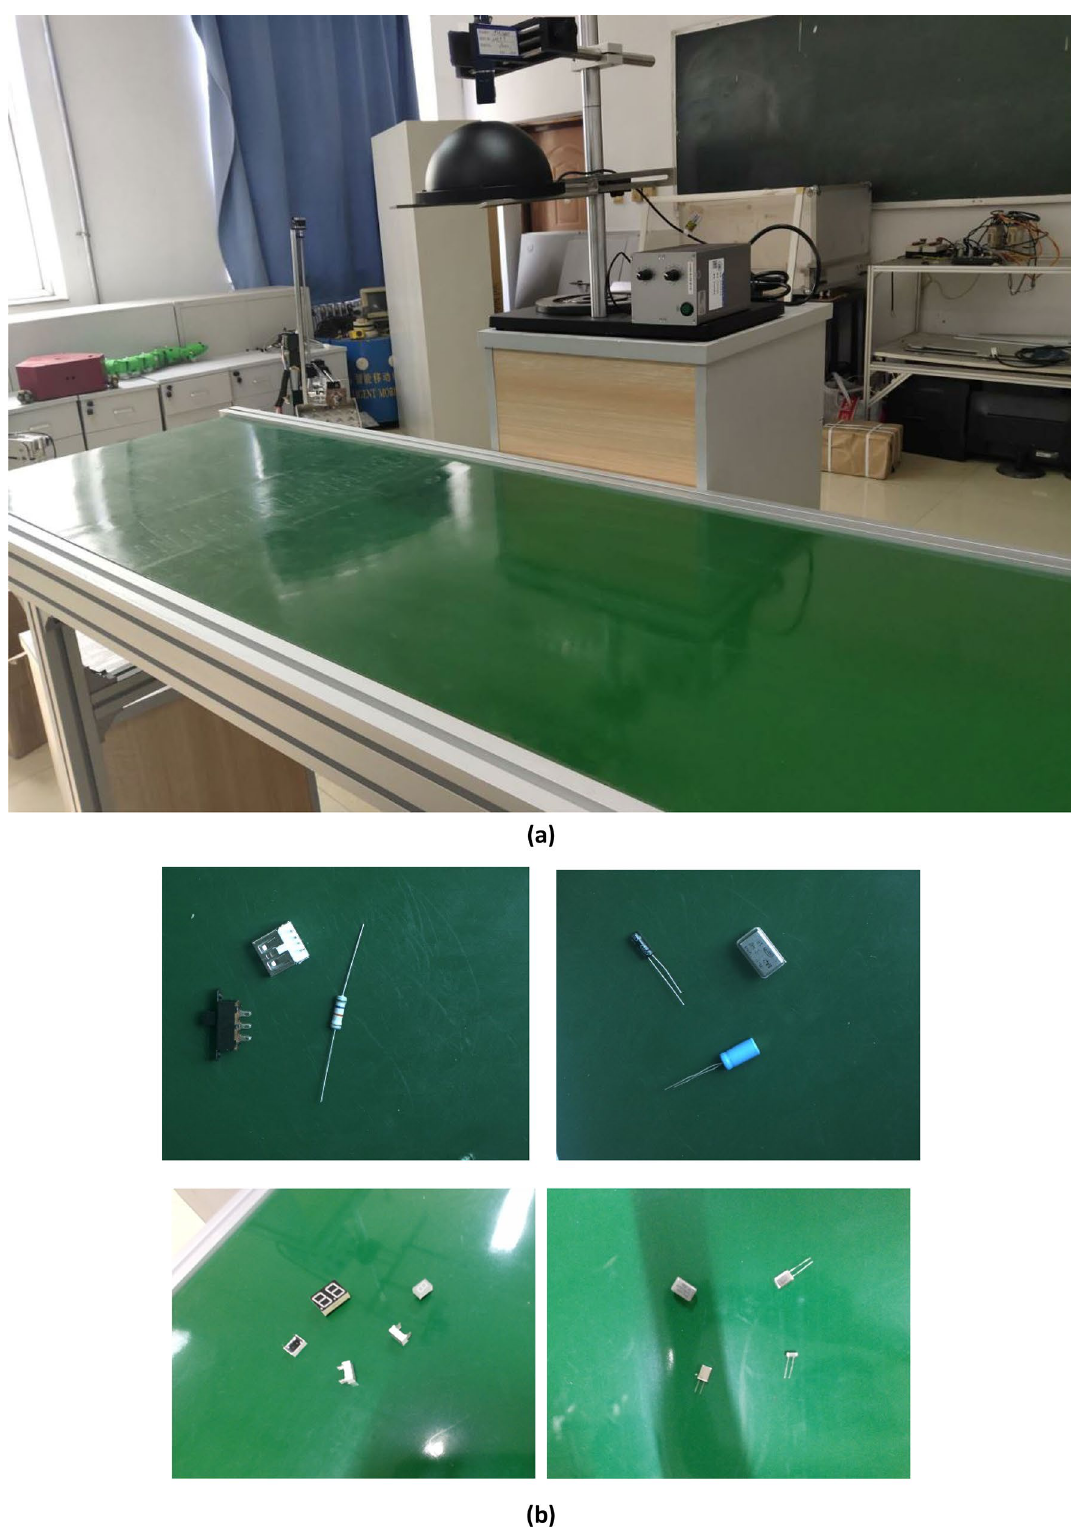
Figure 8. Data set collection. ( a ) A target detection platform was built to simulate an industrial environment. ( b ) The electronic components were placed and the data set was